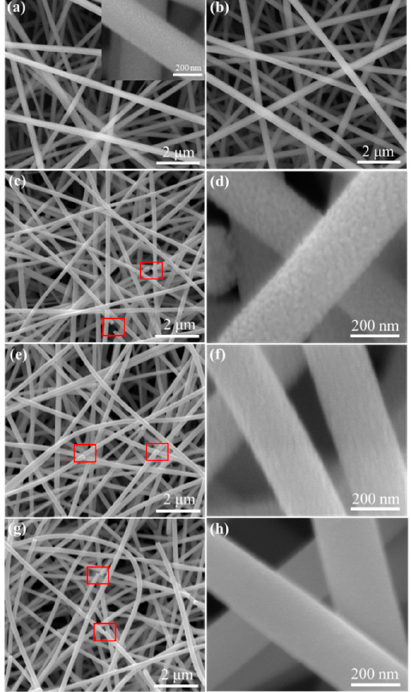
Figure 3. Typical scanning electron microscopy (SEM) images of ( a ) Sn / 0, ( b ) NiSn / 0, ( c ) Sn / 2, ( e ) Sn / 4 and ( g ) NiSn / 4 samples. ( d , f , h ) are the relative high-resolution images of ( c , e , g ), respectively.